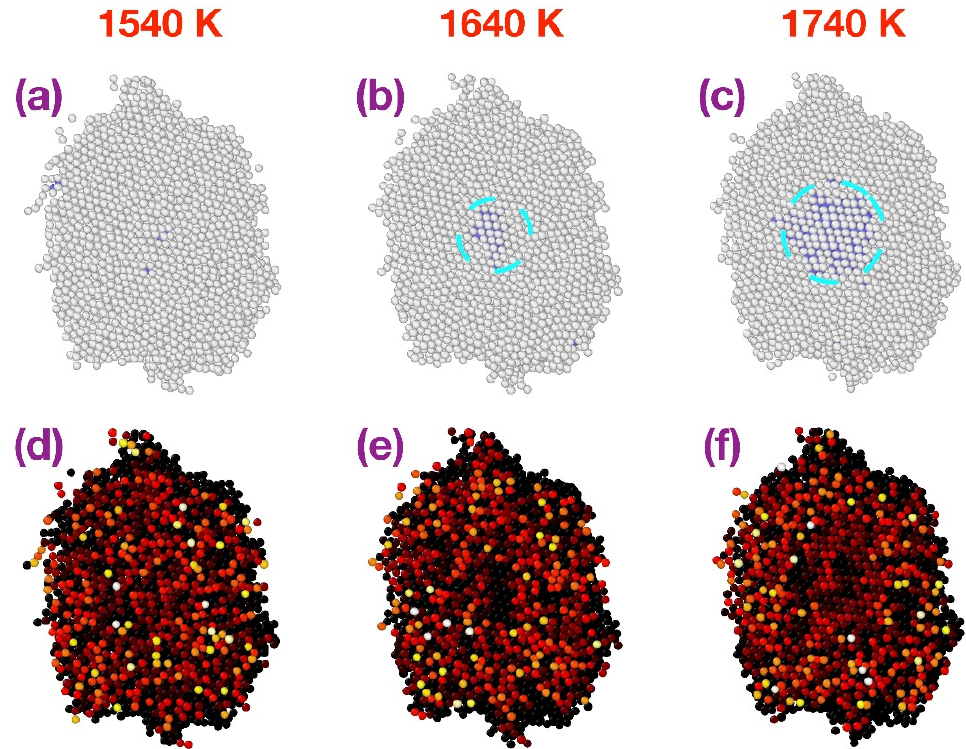
Figure 3. Front view (from outside the surface) of atoms surrounding Grain X (defined in Figure 1) at 1540, 1640 and 1740 K during nucleation and early growth of Grain X . Upper row ( a – c ): local structure (blue—BCC, gray—non-BCC). Lower row ( d – f ): atomic potential energy (E p ) represented by a “hot” color scheme (black-red-yellow-white, in the order of increasing E p ).